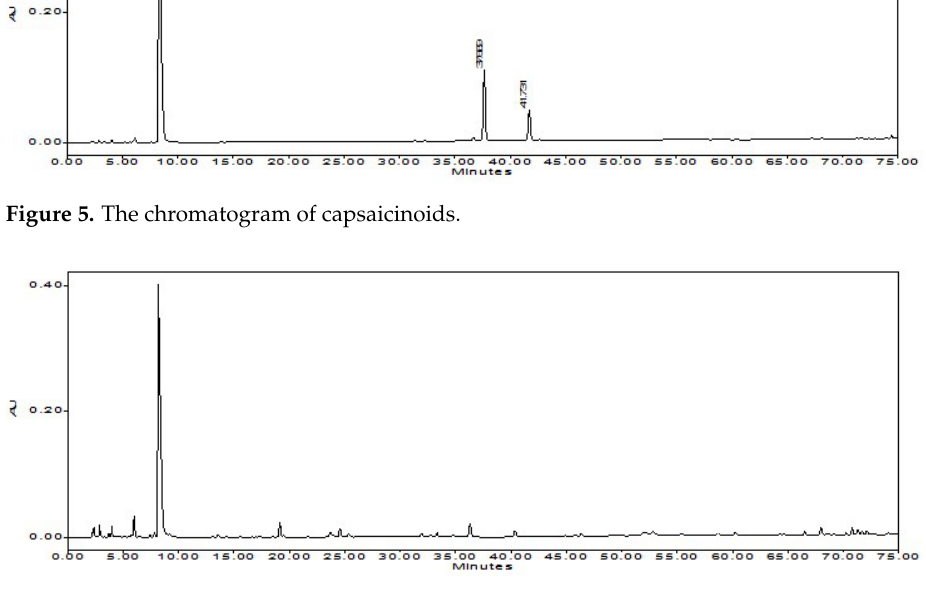
Figure 6. The chromatogram of NHRPO.